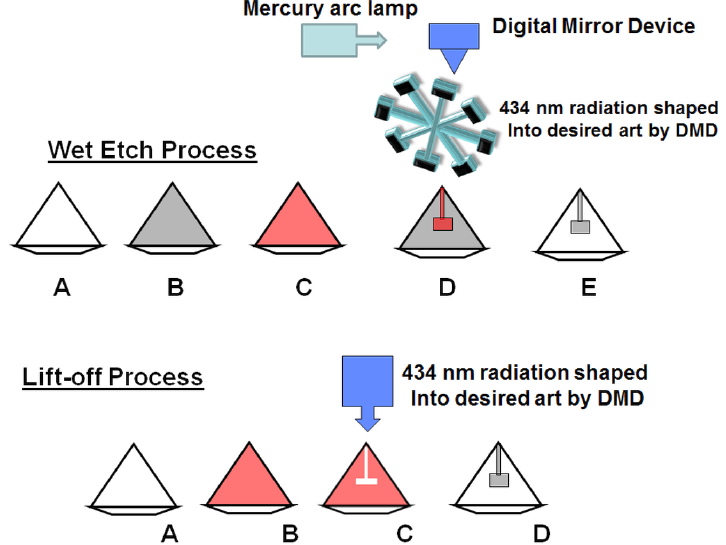
Figure 1. The top row shows the steps involved in fabricating a designer diamond through the wet etch process. The bottom row shows the steps involved in fabricating designer diamond anvils through the lift-off